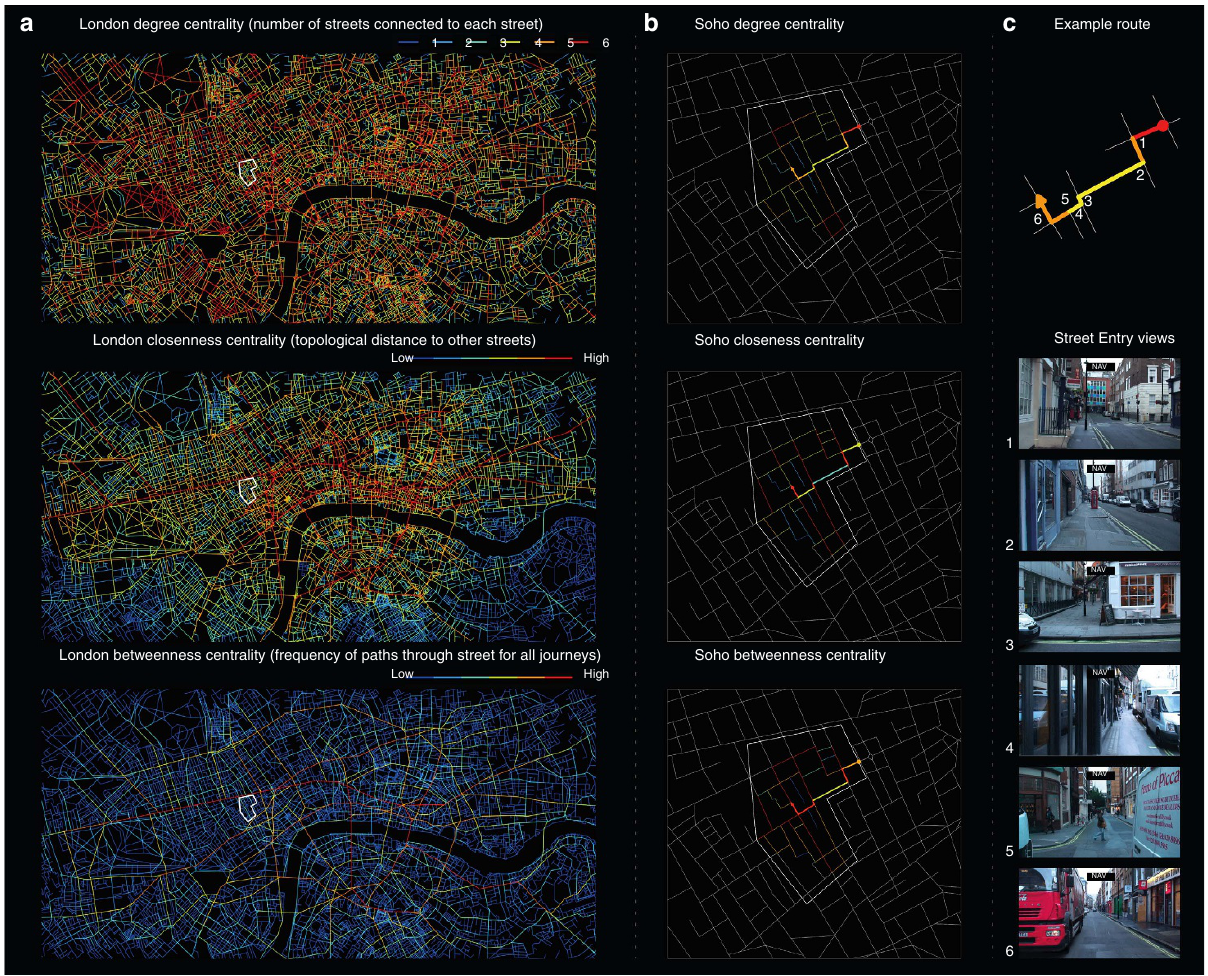
Figure 2 | Graph-theoretic analysis of London (UK) street network centrality and the fMRI navigation task. ( a ) Plots of central London (UK) street segment centrality measures (degree, closeness and betweenness). We used a segment-based approach known as space syntax. Here degree centrality measures the number of connecting segments to any segment, closeness measures how far any two segments are and betweenness measures the number of shortest paths from all segments to all other segments that pass through that segment. See Supplementary Table 1 for the relationship between measures in Soho. White bounded region in each plot indicates the region of Soho learned and navigated during fMRI scanning. See Supplementary Fig. 1 for the frequency of each value of centrality for Central London and this region of Soho. ( b ) Plots of segment centrality measures for the streets navigated in Soho. Thicker lines display an example of one of the 10 routes navigated during fMRI. ( c ) Top: degree centrality of the street segments in the example route plotted with each of the six Street Entry Events marked. Bottom: movie frames from our fMRI navigation task at the six Street Entry Events in the example route